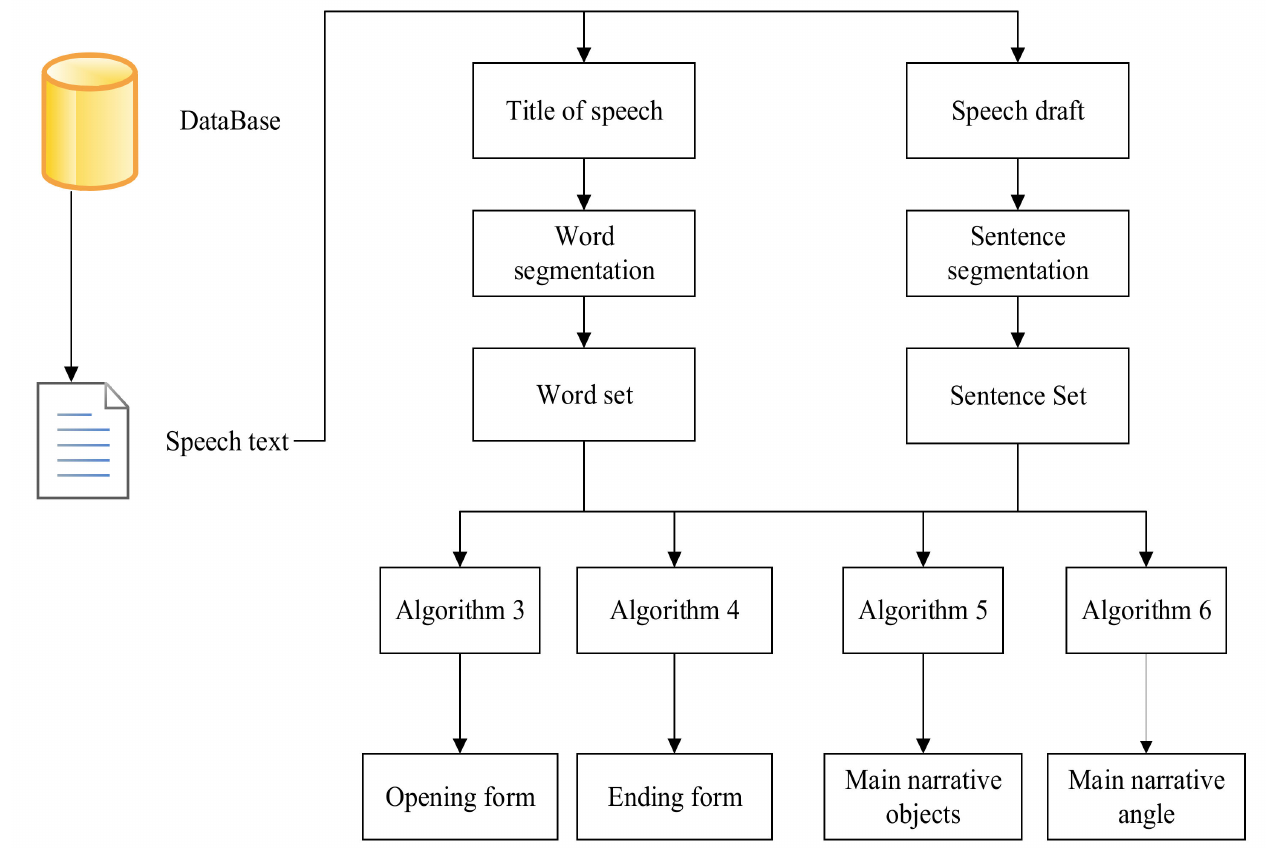
Figure 3. Program flowchart of YiXi talk pattern automatic